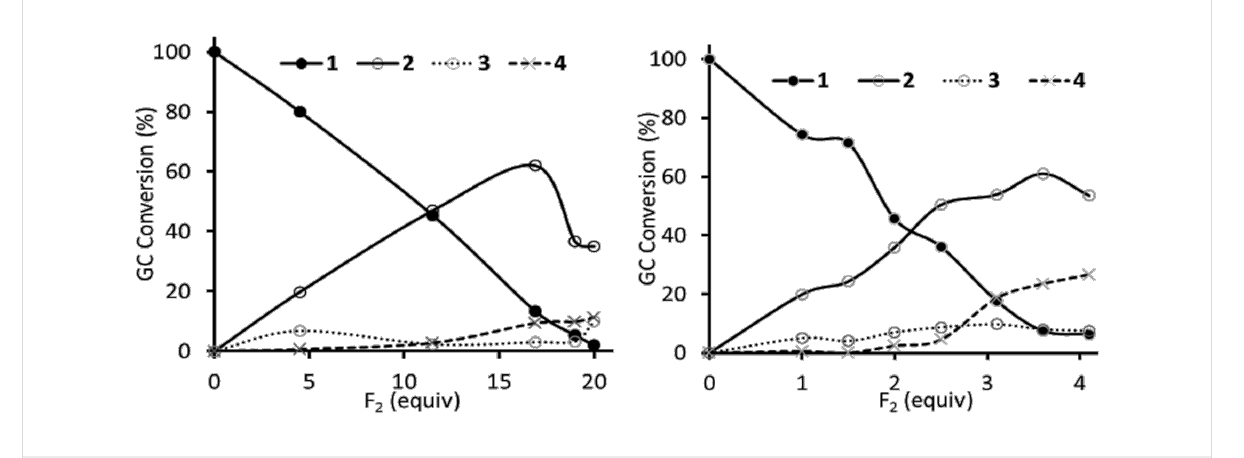
Figure 1: Conversion vs added fluorine equivalents for the fluorination of 1 in MeCN (left) and anhydrous HF